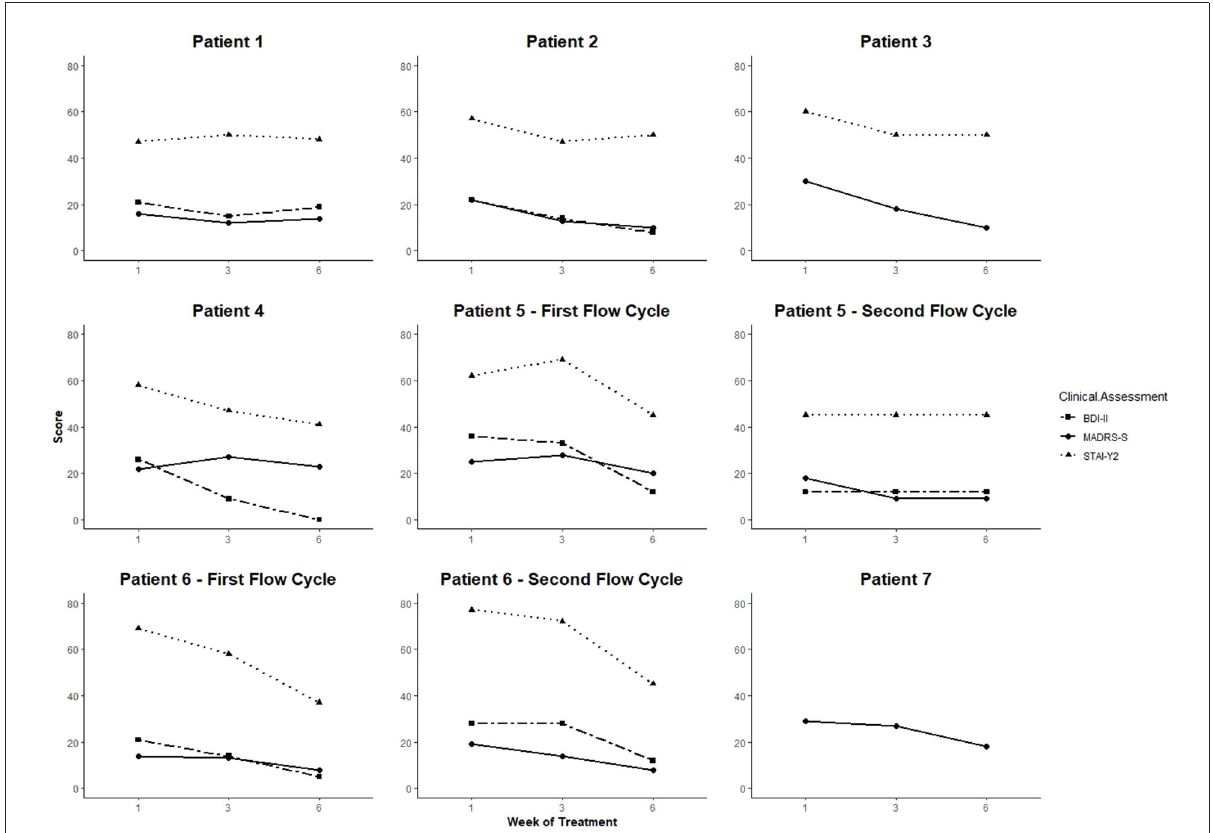
FIGURE1 MADRS-S, BDI-II, and STAI-Y2 results by patient across the Flow treatment. X-axis shows measuring time points, y-axis shows scores. MADRS-S results were not available for patient 7. MADRS interview performed by the clinician is depicted as a proxy value.